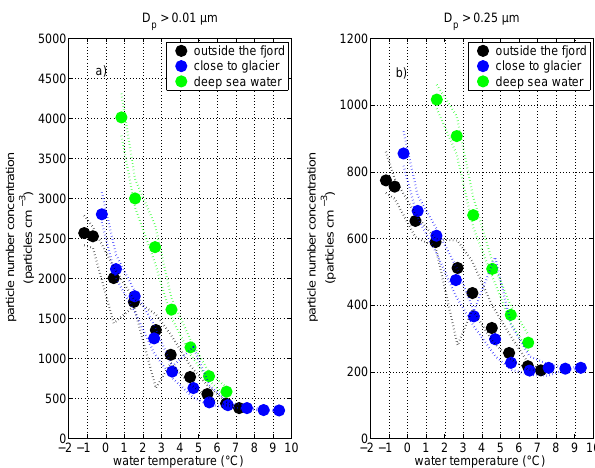
Fig. 4. Medians of particle number concentration for distinct water temperature bins and each experiment. Dashed lines represent 25th and 75th percentiles. The salinity was between 34.3 and 34.4‰ for the sampled water close to the glacier, 34.4 to 34.7‰ for the deep water and 34.1 to 35.0‰ for experiments which were con- ducted using sea water from outside the fjord. (a) Measurements for particles with D p > 0 . 01µm. (b) Measurements for particles with D p > 0 . 25µm. Note the different scales.